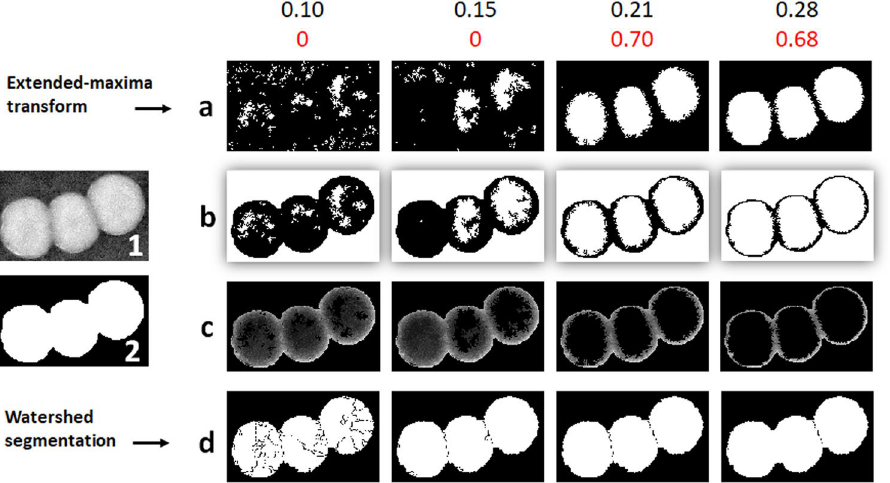
Figure 7. The parameter adaptation for h using criteria (1) and (2). Image 1 is the original grayscale image of the chunk of colonies and image 2 represents the initial BLOB detected. Values in black are the H-maxima transform ( h i ) and red values represent the quality of segmentation ( Q 1 ( h i )). Row ( a ) shows the result of applying hole filling operation after using extended-maxima transform at different h i . Row ( b ) shows just the representation of selected seed points using an OR operation of seed points image with the complement of the mask. Row ( c ) shows the result of imposing minima operation on complemented grayscale image and the OR combination of complemented mask with the seed points image. The final result of applying watershed algorithm from the image obtained from preceding step is shown in the last row ( d ). Here, h i = (0.1, 0.15, 0.21, 0.28) were selected to show the affect of using different h i on the quality outcome Q 1 ( h i ). It can be seen from this example, that the best result Q 1, opt = 0.70 is obtained at h i = h opt =